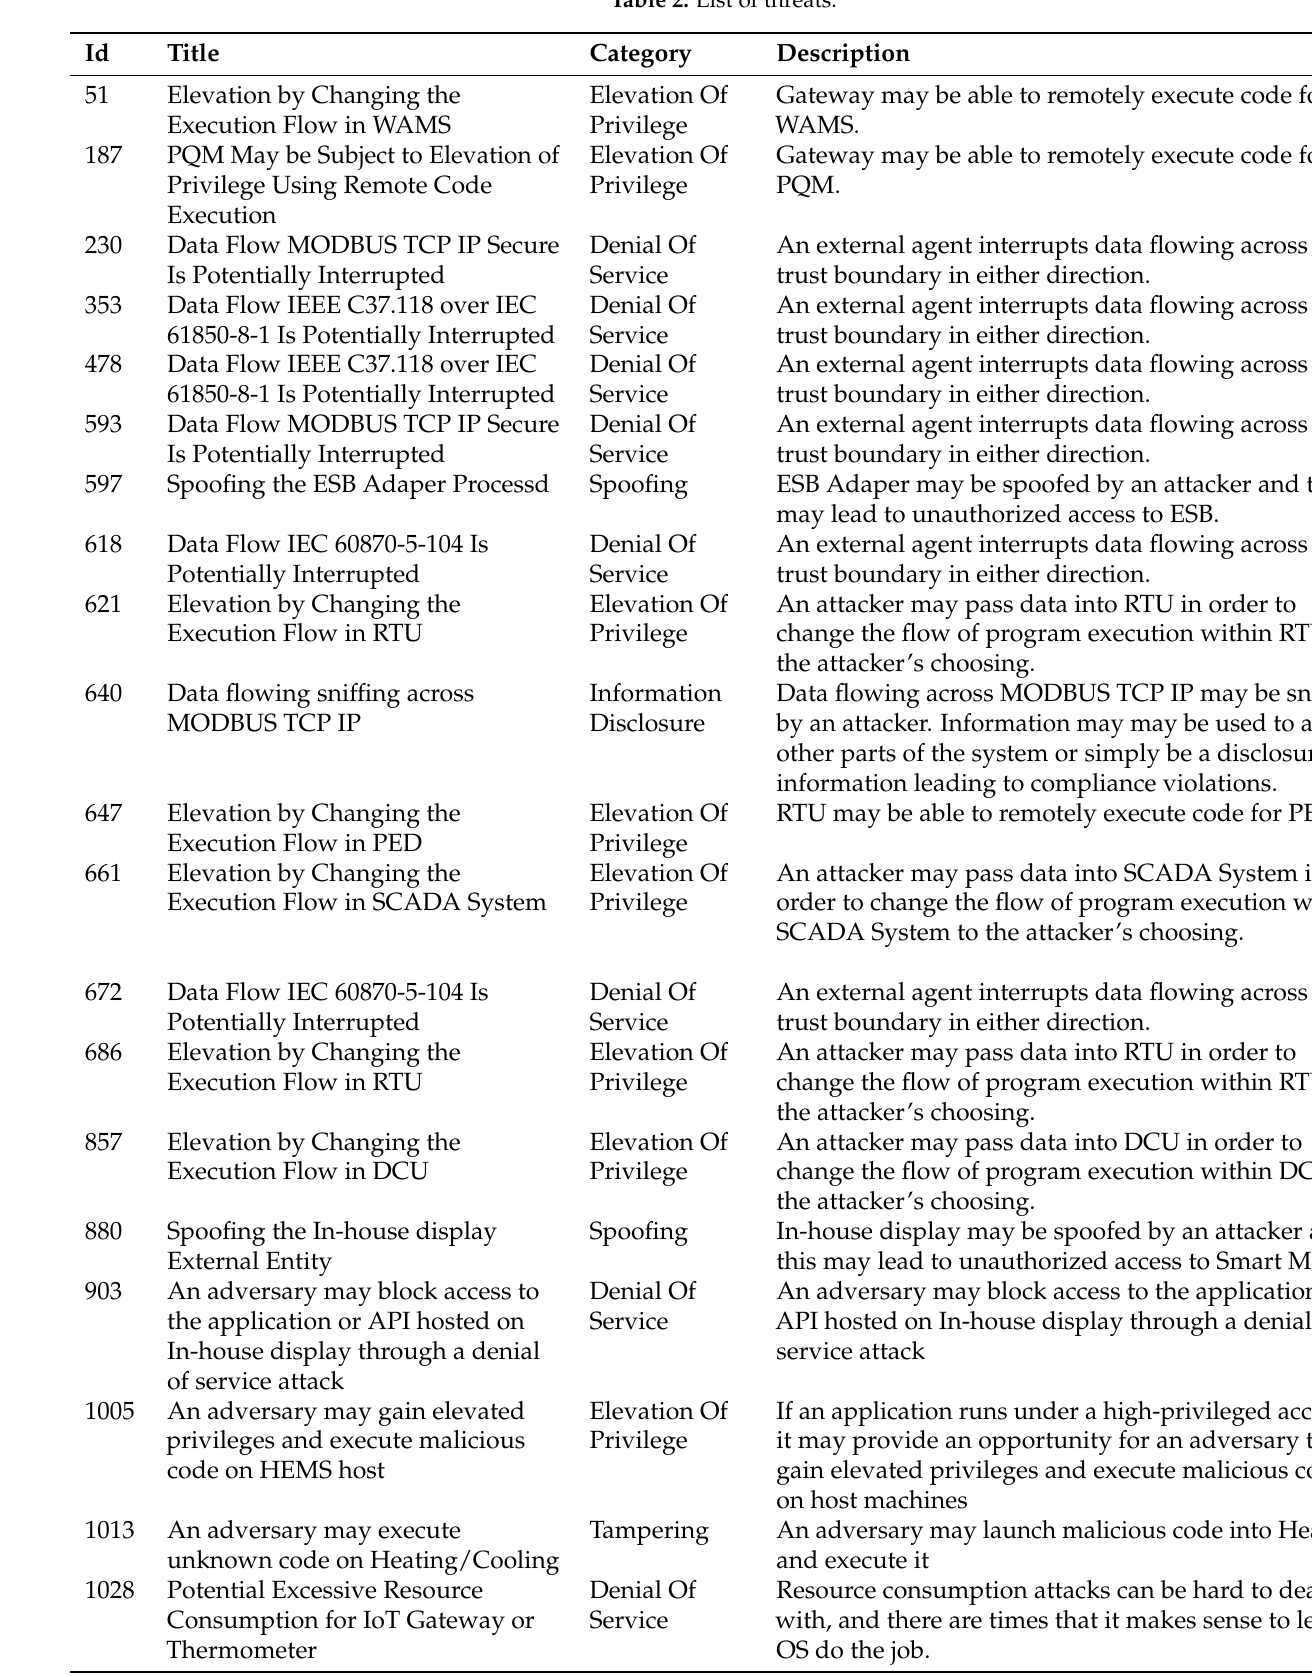
Table 2. List of